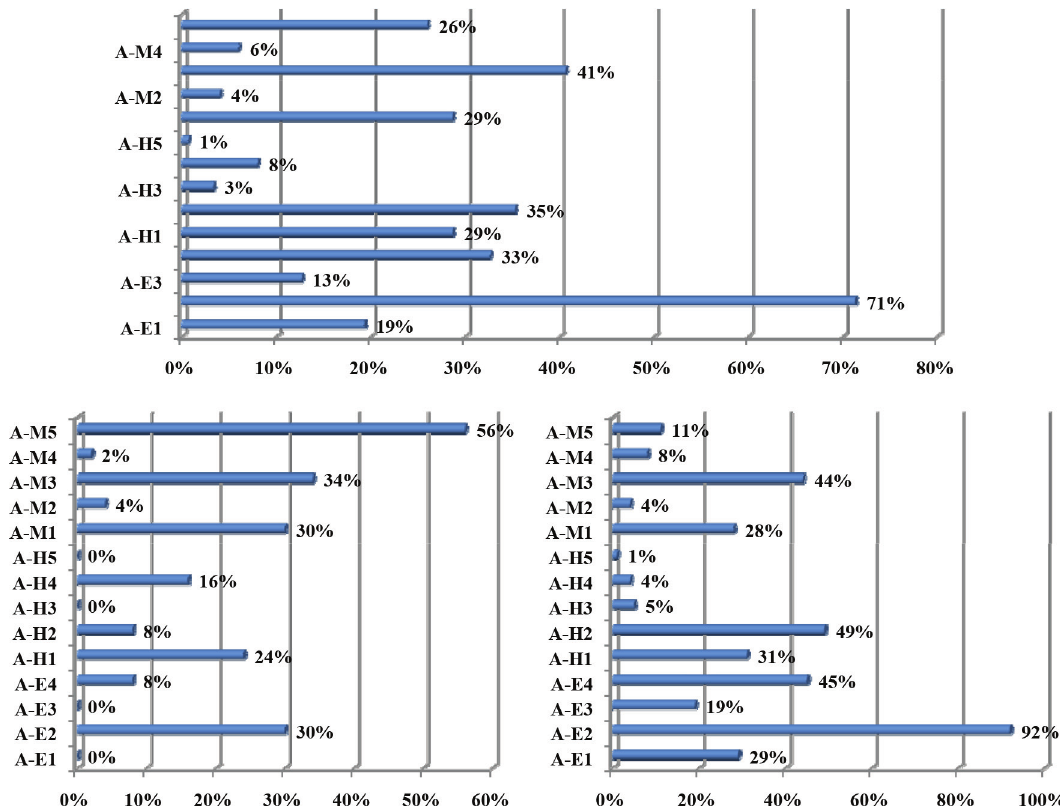
Fig. 3. Probability of finding each anomaly in one wall: consideringall surfaces (top), in interior surfaces (down left) and in external surfaces (down